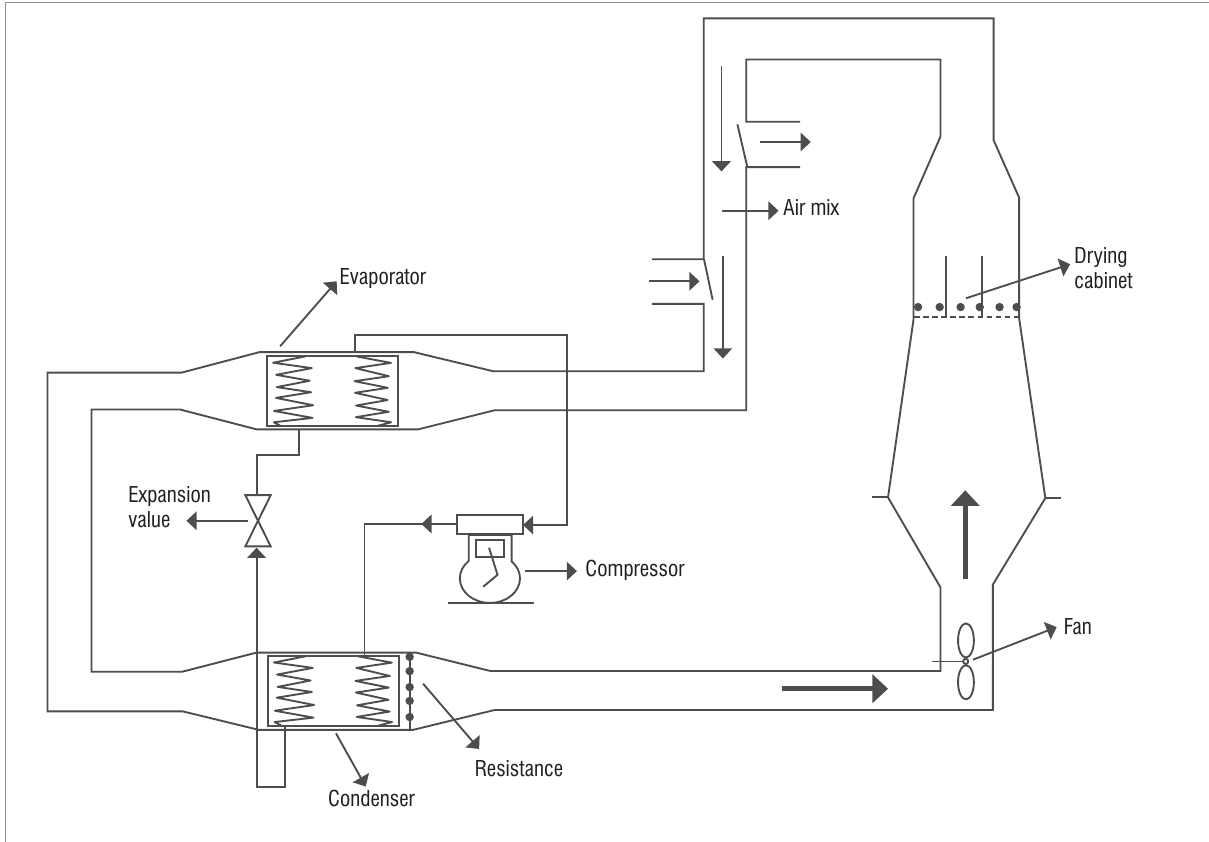
Figure 2: A closed-cycle heat pump dryer.